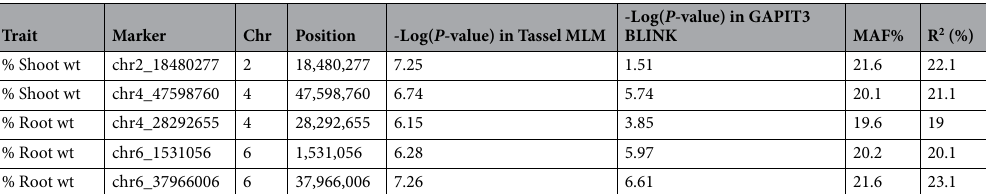
Table 1. SNP markers associated with % changes in shoot and root weights in spinach accessions, based on two models, MLM in Tassel 5 and BLINK in GAPIT 3.